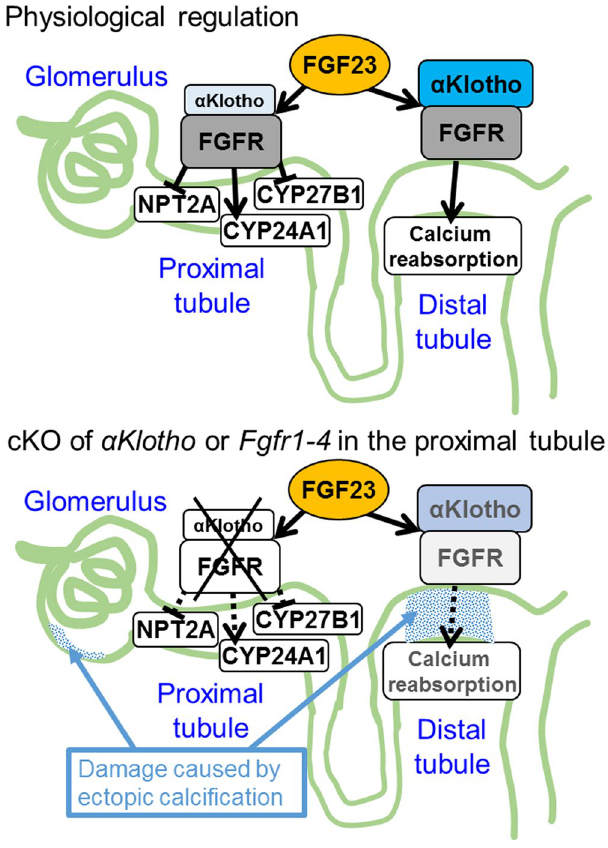
Figure 7. A scheme showing our results that FGF23 directly acts on proximal tubular cells. FGF23 plays critical roles in phosphate handling and vitamin D metabolism in the kidney. However, the effector cells of FGF23 have been controversial. α Klotho, a putative enzyme possessing β -glucuronidase activity and also a permissive co- receptor for FGF23 to bind to FGF receptors (FGFR), is most abundantly expressed in distal tubules whereas modestly in proximal tubules. FGFR are expressed in both proximal and distal tubules. The expression of a phosphate transporter, NPT2A, and vitamin D-metabolizing enzymes, CYP27B1 and CYP24A1, is confined to proximal tubules. The stimulatory effect of FGF23 on calcium reabsorption in distal tubules has been demonstrated by others 17,18 and included in the scheme. Here, as shown in the bottom panel, we demonstrate, using Cre-loxP-mediated postnatal ablation of α Klotho or Fgfr1-4 specifically from proximal tubular cells, that the primary function of FGF23 on phosphaturic effect and vitamin D metabolism is mediated through α Klotho/FGFR co-receptors expressed in proximal tubular cells. However, the resulting intra-renal ectopic calcification presumably damages the function of distal tubules, glomeruli and vasculature. T-shaped lines and arrowhead lines indicate inhibition and stimulation, respectively. Dotted lines indicate functional weakening or abrogation. Both α Klotho and FGFR are membrane-intercalated